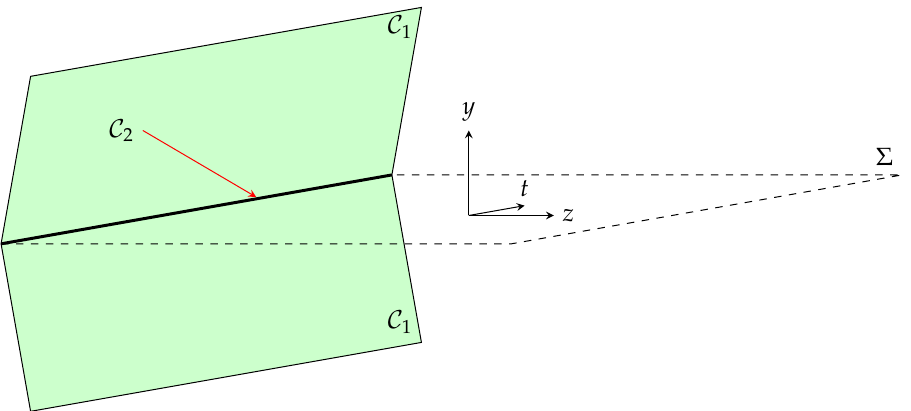
Figure 1. Pictorial representation of the configuration and of the coordinate